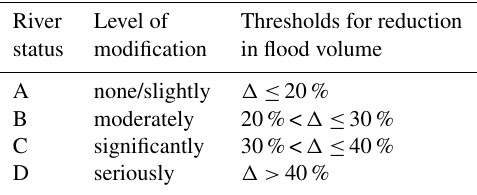
Table 1. Thresholds for different levels of mean annual flood vol- ume deviation ( (cid:49)) between modified and natural flow regimes (as suggested for global assessments by Hoekstra et al., 2011).